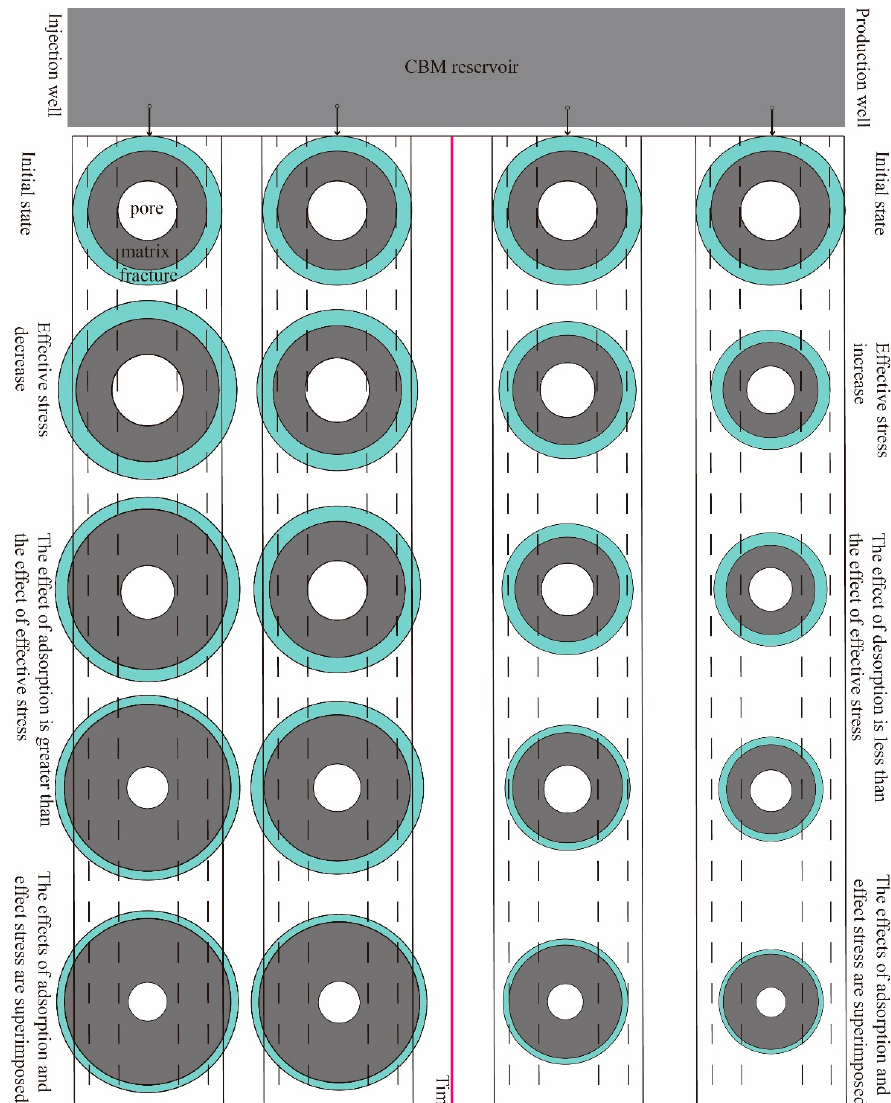
Figure 17. The schematic of porosity/permeability evolution at different locations in the CBM reservoir during the process of CO 2 -ECBM recovery.